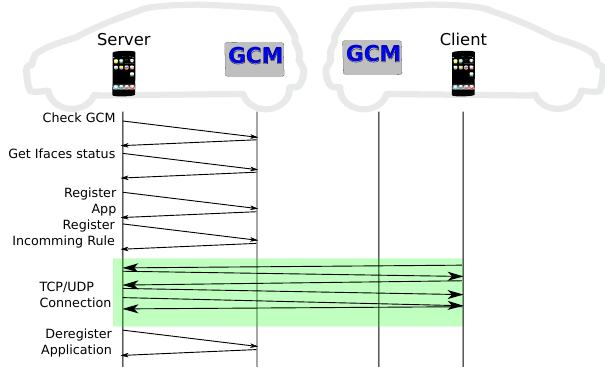
Figure 3: Example of a client GRCBox application con- necting to a